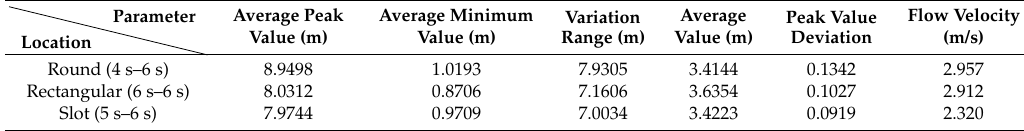
Table 15. Flushing results when different shape nozzles are set at the bottom of the pipe.